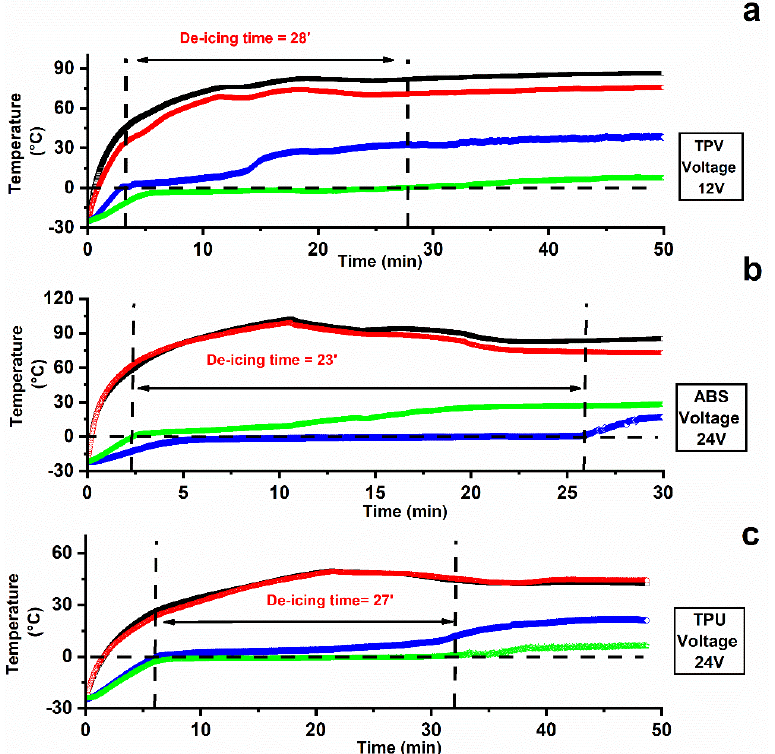
Figure 11. De-icing results at constant DC voltage on sheet-shaped specimens ( a ) TPV12; ( b ) ABS12; ( c ) TPU12.